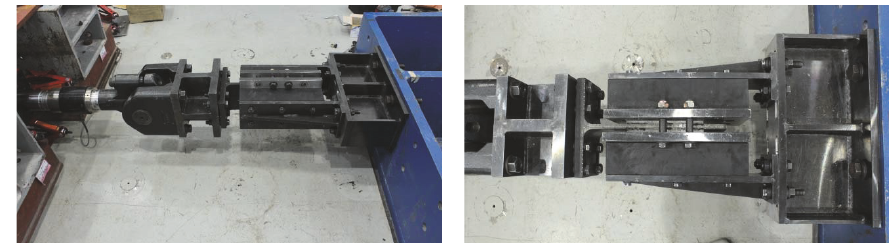
Figure 9: Cyclic loading tests of the typical